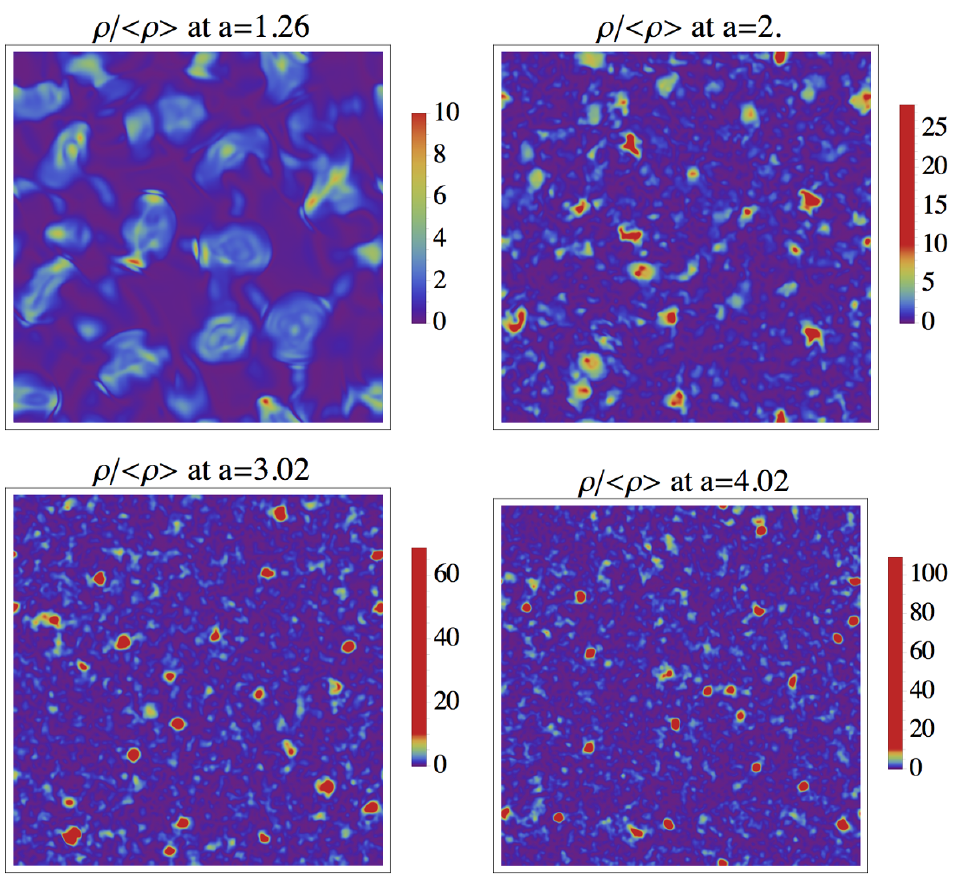
Figure 14 . Four snapshots of the energy density in a 2d simulation for our LVS blow-up modulus example at a = 1 : 26, a = 2, a = 3 : 02 and a = 4 : 02. Clearly, asymmetric oscillons are formed at a (cid:24) 3. Videos of the simulations can be found here [61].